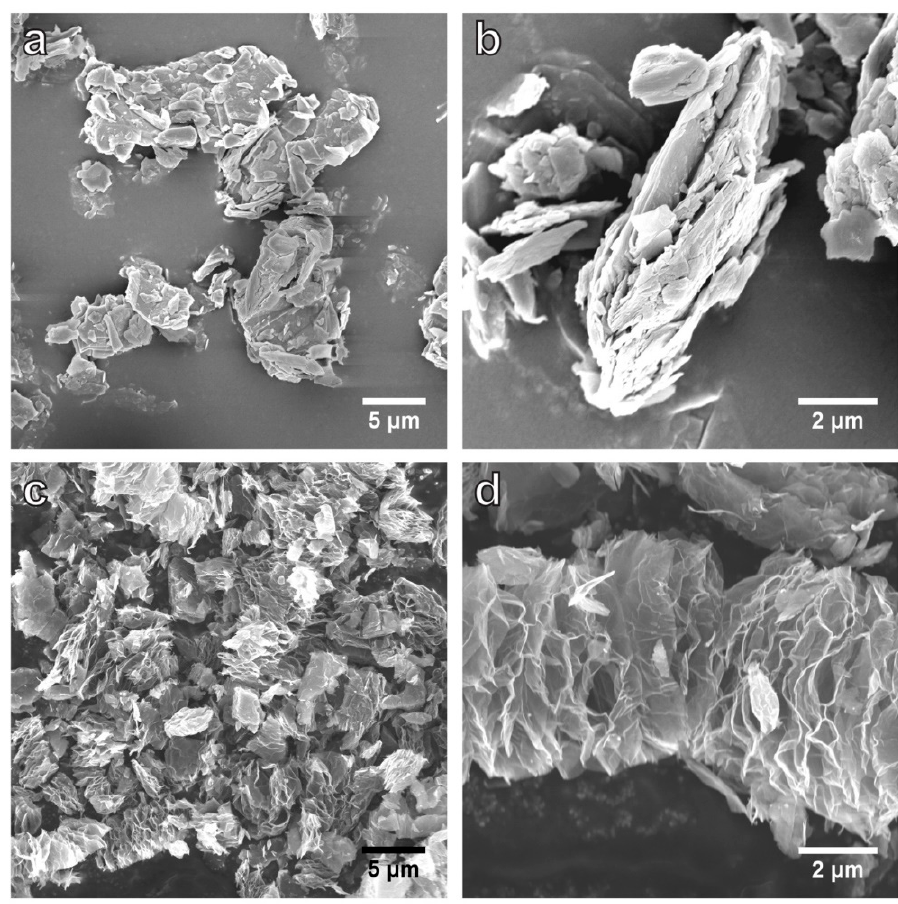
Figure 2. SEM images of GF ( a , b ) and MEGF ( c , d ). The MEGF shows a heavily expanded structure due to the rapid release of evolved gases expanding the layers along the c-axis direction after the graphite-mediated